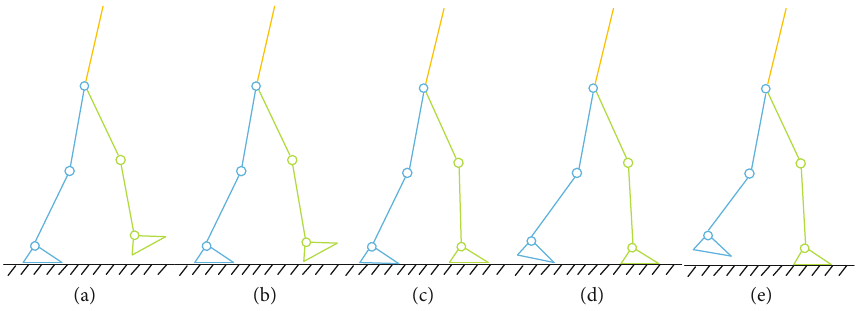
Figure 1: Multiple walking phases. (a) Left leg support. (b) Right heel strike. (c) Double leg support. (d) Left toe o ff . (e) Right leg support.